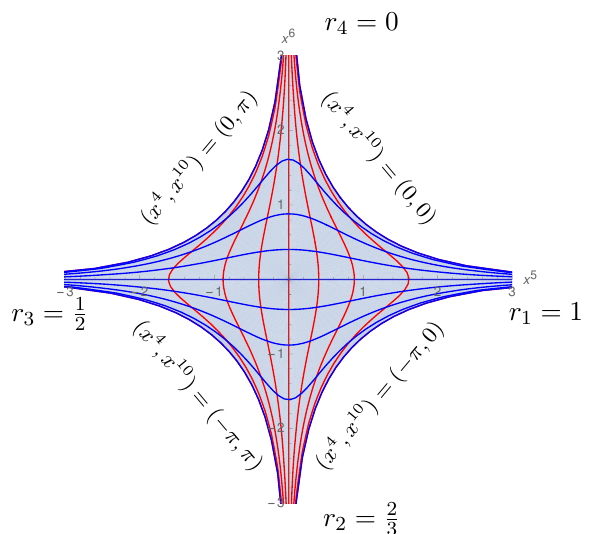
Figure 5. + 1 ; 1 curve with ~ R 4 = R 10 = 1 obtained by embedding (cid:6) IIB into M 4 via (3.8). The poles r ‘ on (cid:6) IIB correspond to the external 5-branes as indicated. The segments of @ (cid:6) IIB in between poles are mapped to the outer curves connecting the asymptotic regions, with x 4 , x 10 as indicated. The blue and red curves correspond to constant x 4 and x 10 , respectively. The embedding of the second half of ^(cid:6) IIB , with w in the lower half-plane, is obtained via